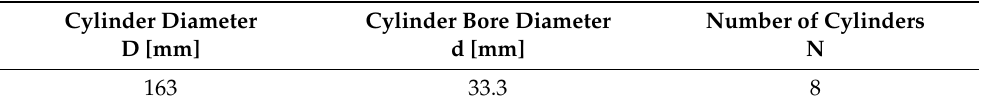
Table 3. Cylinder size.